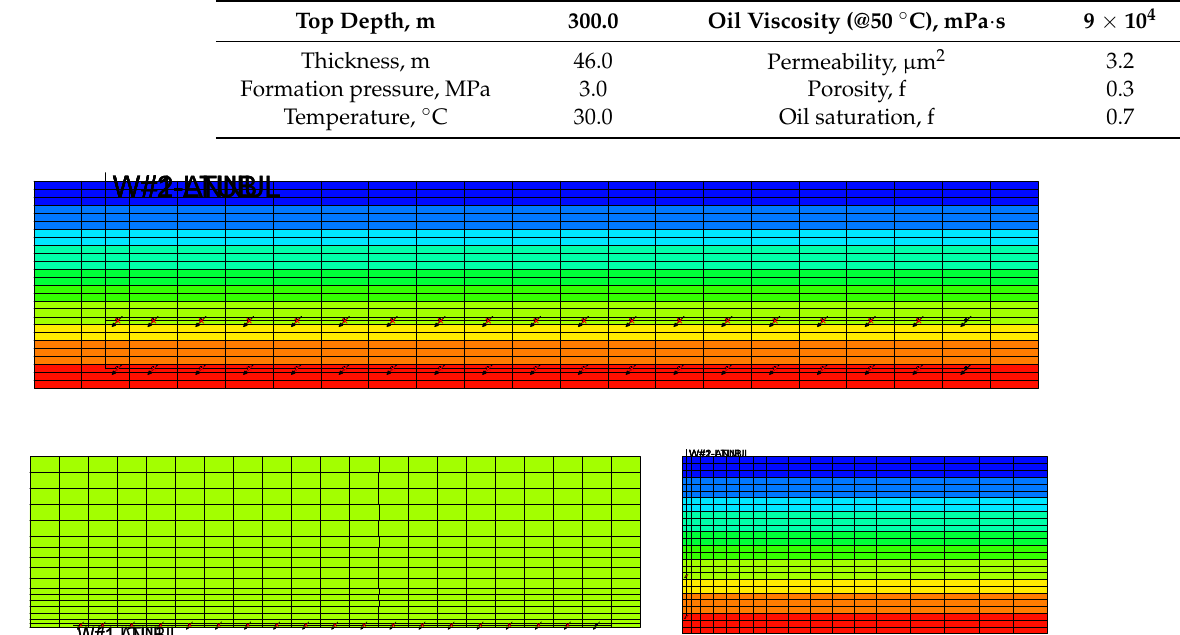
Figure 10. Oil viscosity between injection and production well.